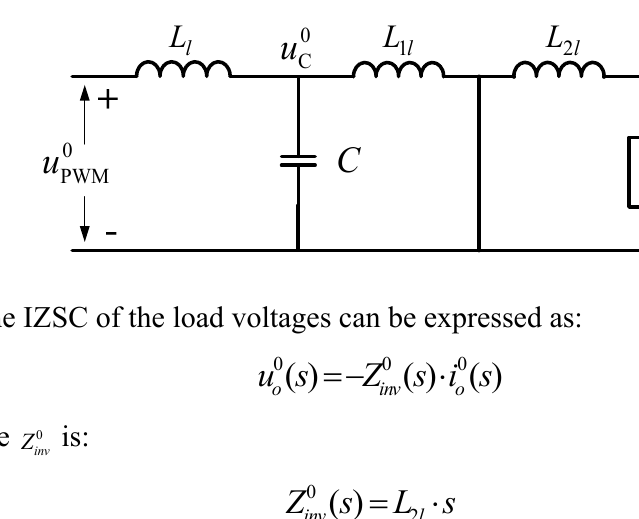
Figure 9. IZSC equivalent circuit for three-phase inverters with instantaneous feedback